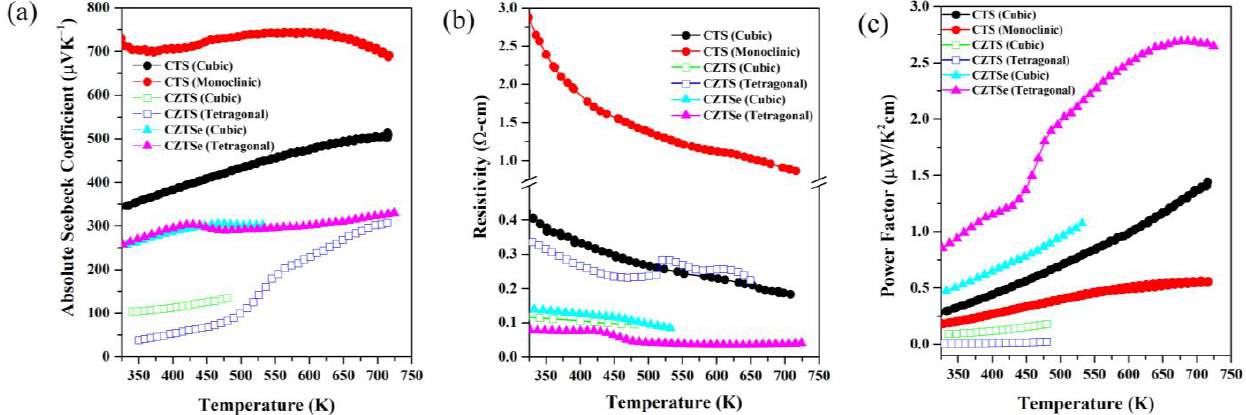
Figure 4. Temperature-dependent Seebeck coefficient ( a ), electrical resistivity ( b ), and power factor ( c ) curves for CTS, CZTS, and CZTSe polymorphs retrieved from [20,34,51,52].